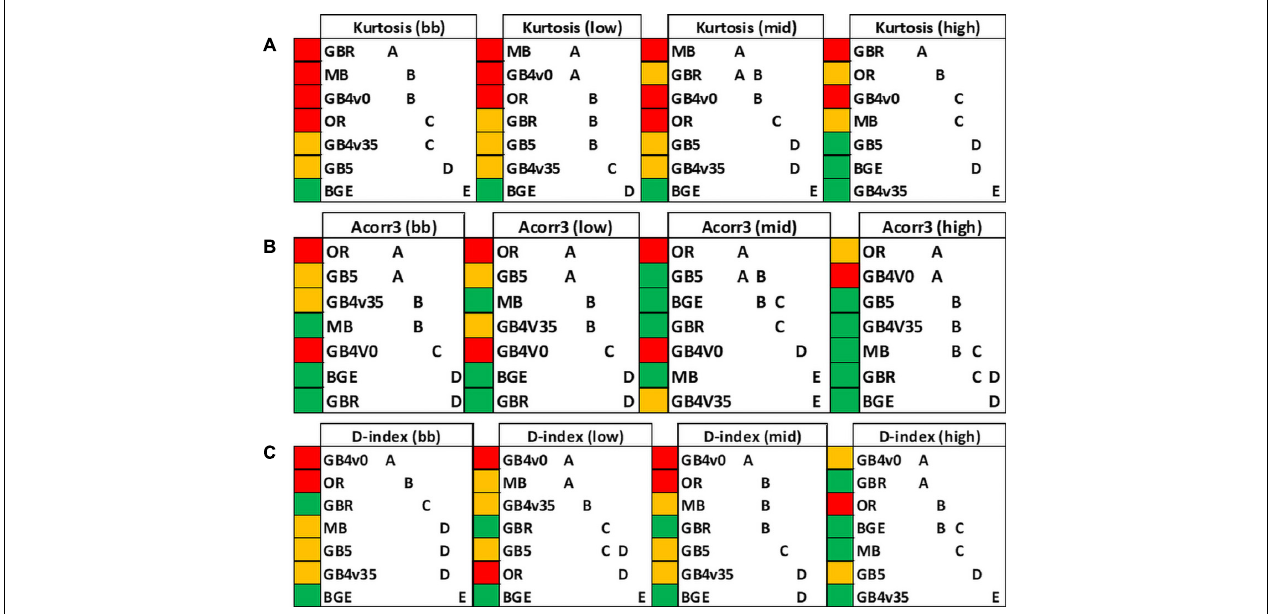
FIGURE 10 | Connected letters plot showing results from multiple comparisons tests for (A) kurtosis, (B) acorr3, and (C) D-index. Sites connected by identical letters were determined by the multiple comparisons tests to have 1-min metric values that are not significantly different. Connected letters within but not across each frequency band form groupings of sites based on metric values. Color bars corresponding to the a priori expectations detailed in Figure 3 were provided to demonstrate how the quantitative site groupings of the multiple comparisons tests compared to the a priori expectations. The colors indicate the expected level of the metric response where green indicates a low property level, yellow indicates a mid-level, and red indicates high-level responses.